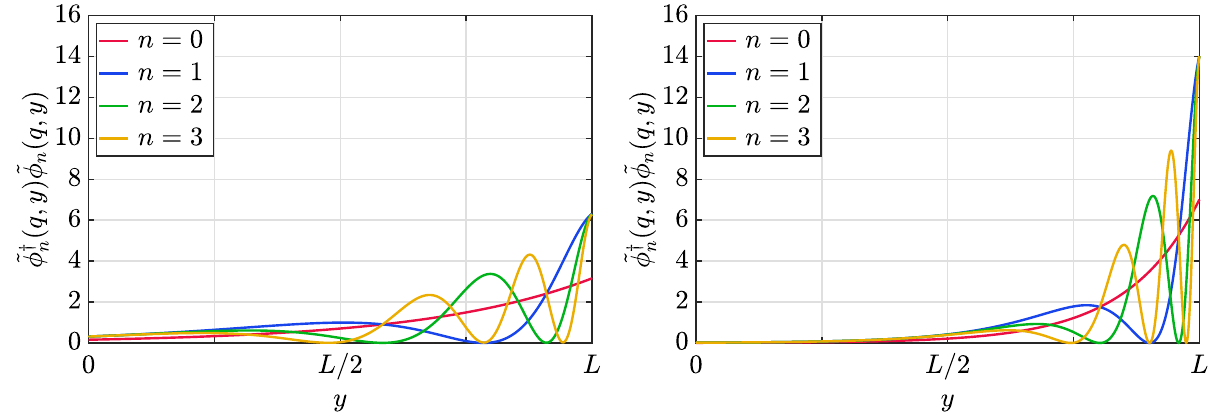
Figure 2. Plots of the probability distribution for the first four stationary states, with positive energy and a value 3 on the left and for kL 10 , for kL of q = =